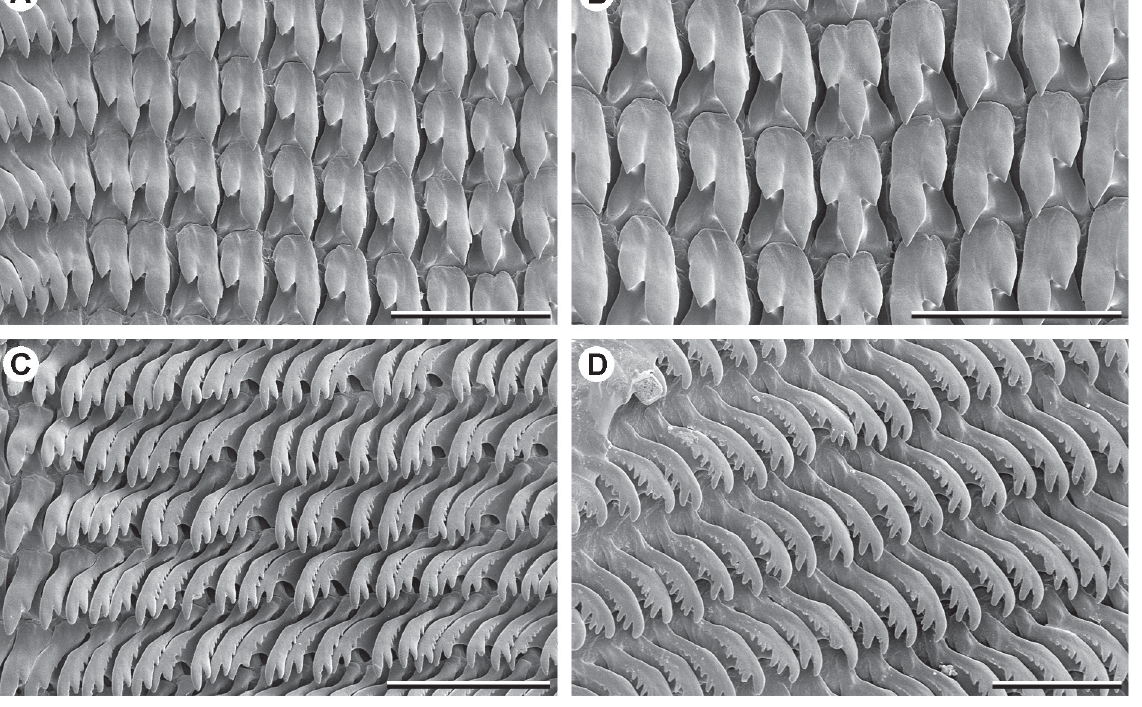
Fig. 15. Sheldonia wolkbergensis sp. nov., radula, holotype (NMSA P0156/T4074). A . Rachidian and lateral teeth. B . Rachidian and innermost lateral teeth. C . Inner marginal teeth. D . Outer marginal teeth. Scale bars: A–C = 50 µm; D = 25